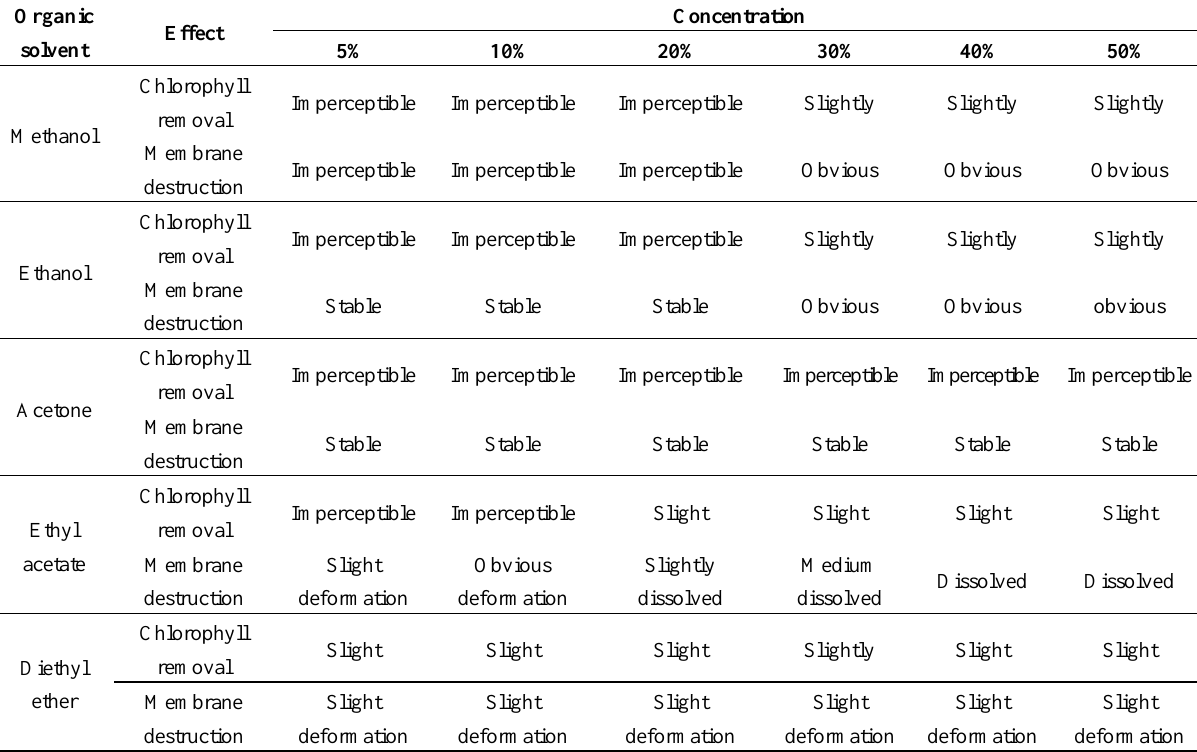
Table 2. Effect of chlorophyll removal and NC membrane destruction by organic